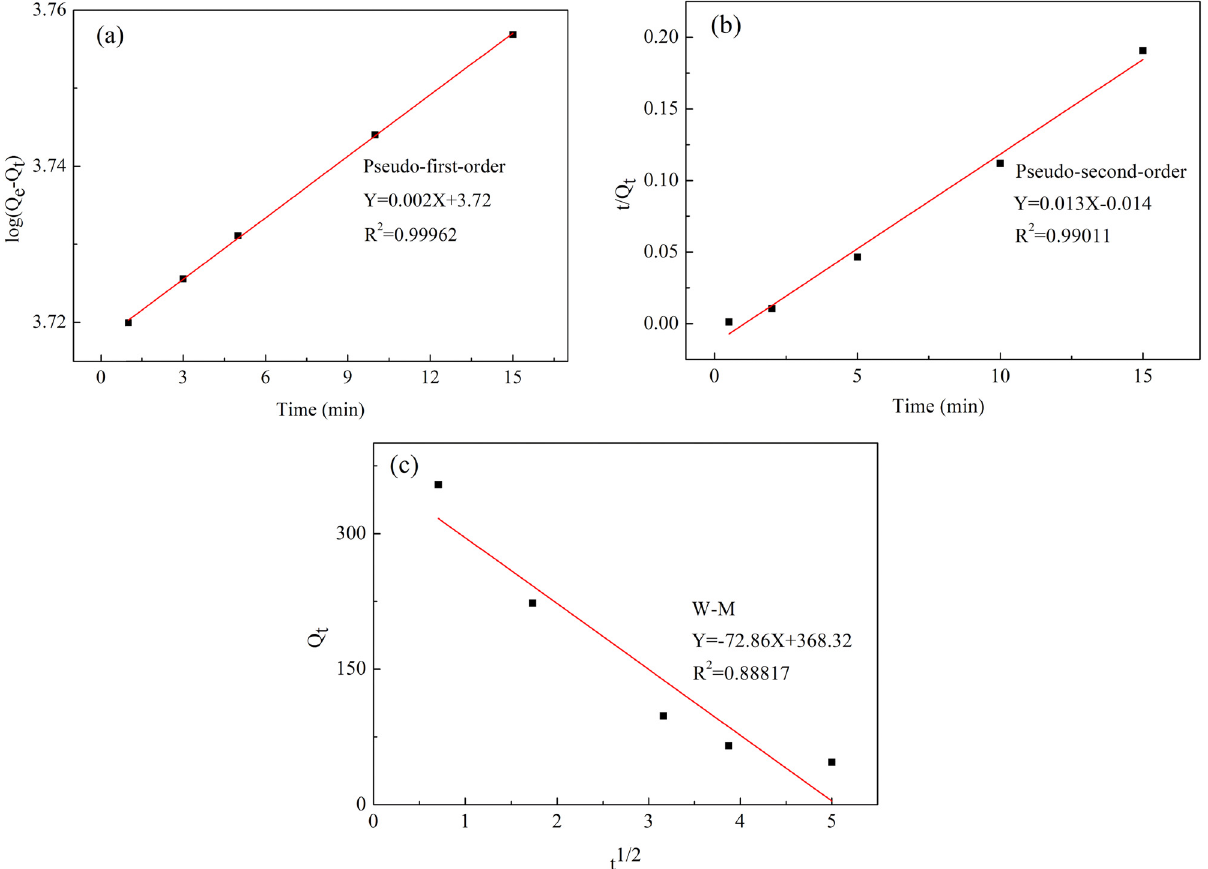
Figure 9: ( a ) Pseudo - fi rst - order model, ( b ) Pseudo - second - order model, and ( c ) Ion di ff usion model.